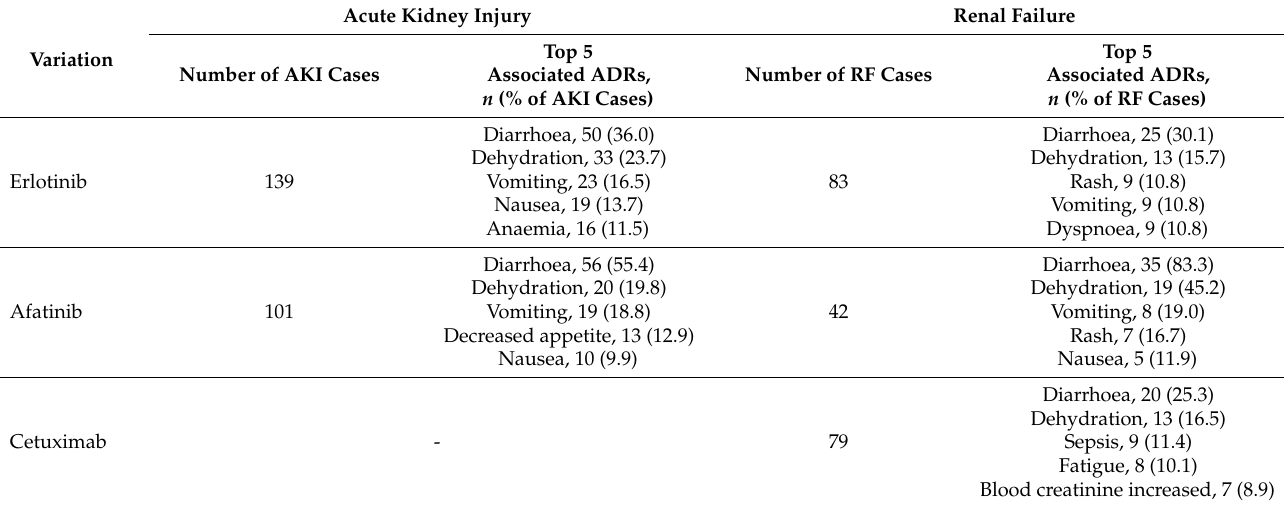
Table 3. Associated adverse drug reactions reported in acute kidney injury and renal failure cases. ADR: adverse drug reaction; AKI: acute kidney injury; RF: renal